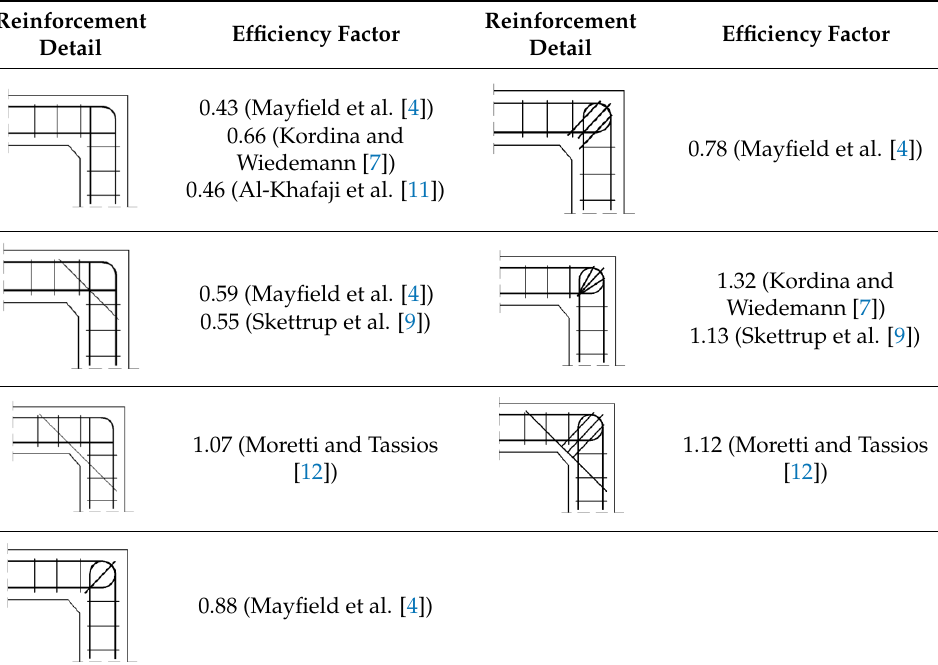
Table 1. Corner efficiency factors obtained in the laboratory tests of various authors. Reinforcement Detail